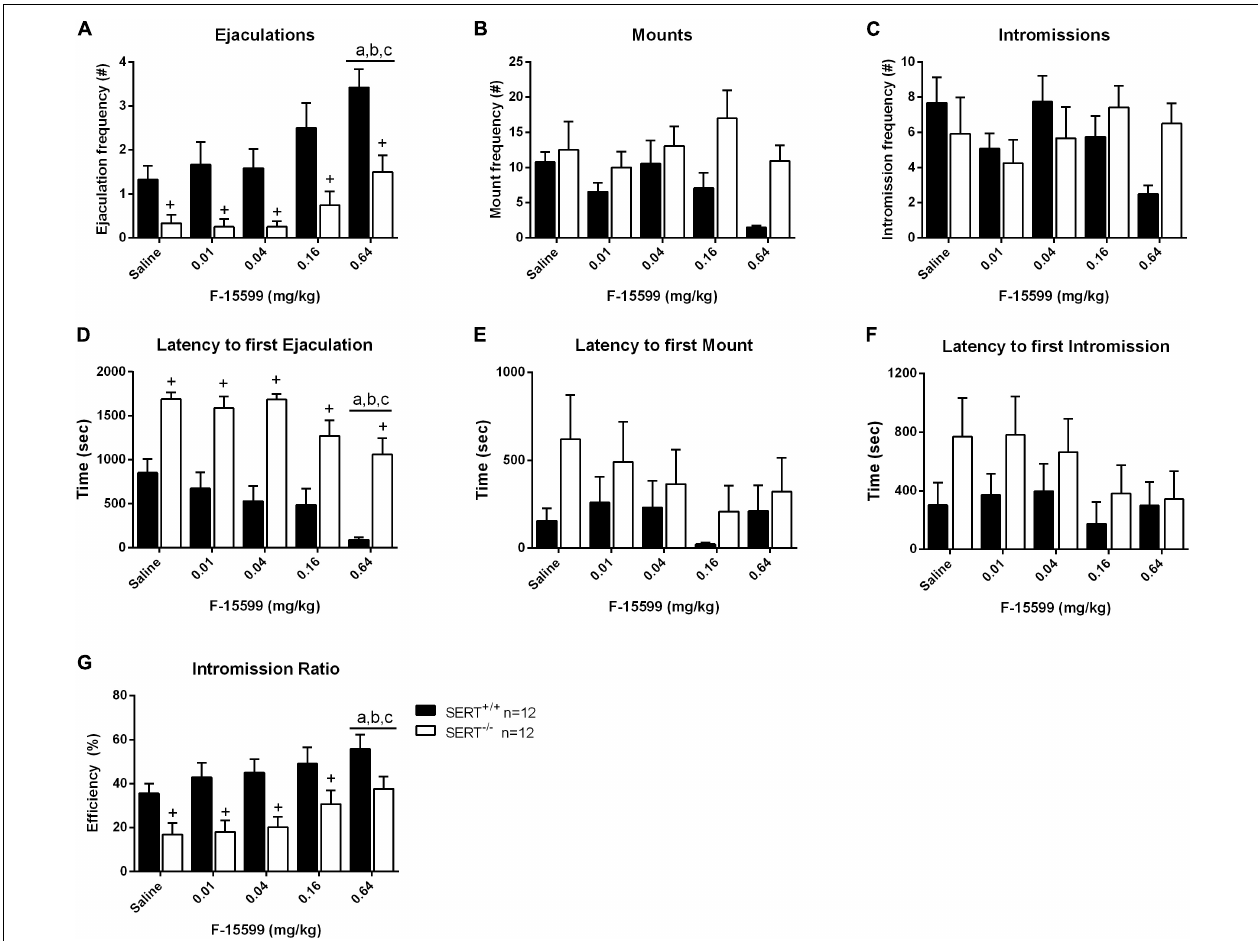
FIGURE 3 | Sexual behavior of male rats treated with 0, 0.01, 0.04, 0.16, or 0.64 mg/kg, IP of F-15599. The number and latency of ejaculations per 30 min (A,D) , number and latency of Mounts (B,E) , number and latency of Intromissions (C,F) and Intromission Ratio (G) of the first Ejaculation Series are displayed. Detailed statistical analyses are provided in Supplementary Table 1 . a: significant difference ( p < 0.05) compared to saline group, b: significant difference ( p < 0.05) compared to 0.01mg/kg group, c: significant difference ( p < 0.05) compared to 0.04/mg/kg group. +Significant difference between SERT + / + and SERT − / − ( p <